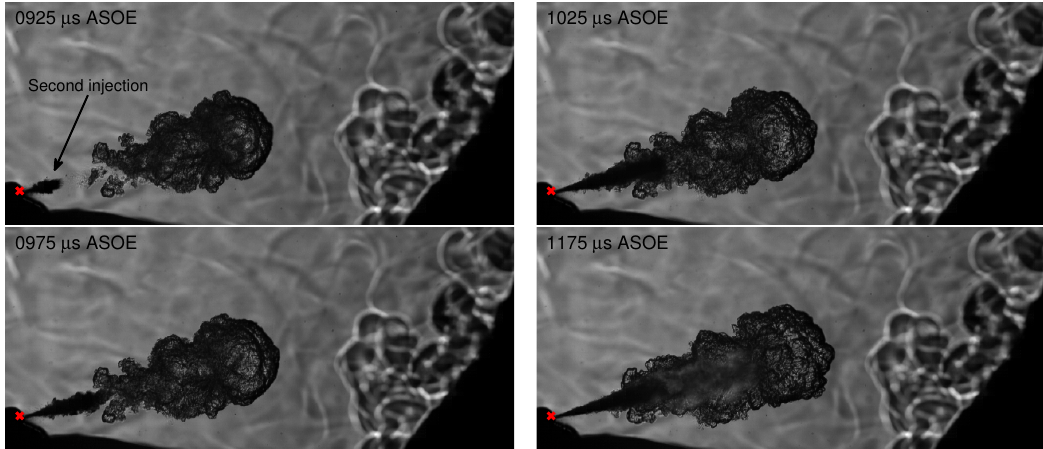
Figure 5. Example of the images gathered through schlieren for multiple injections, starting near the start of injection (SOI) of the second pulse. The frames are for a 1–29 pilot-main event, a dwell time